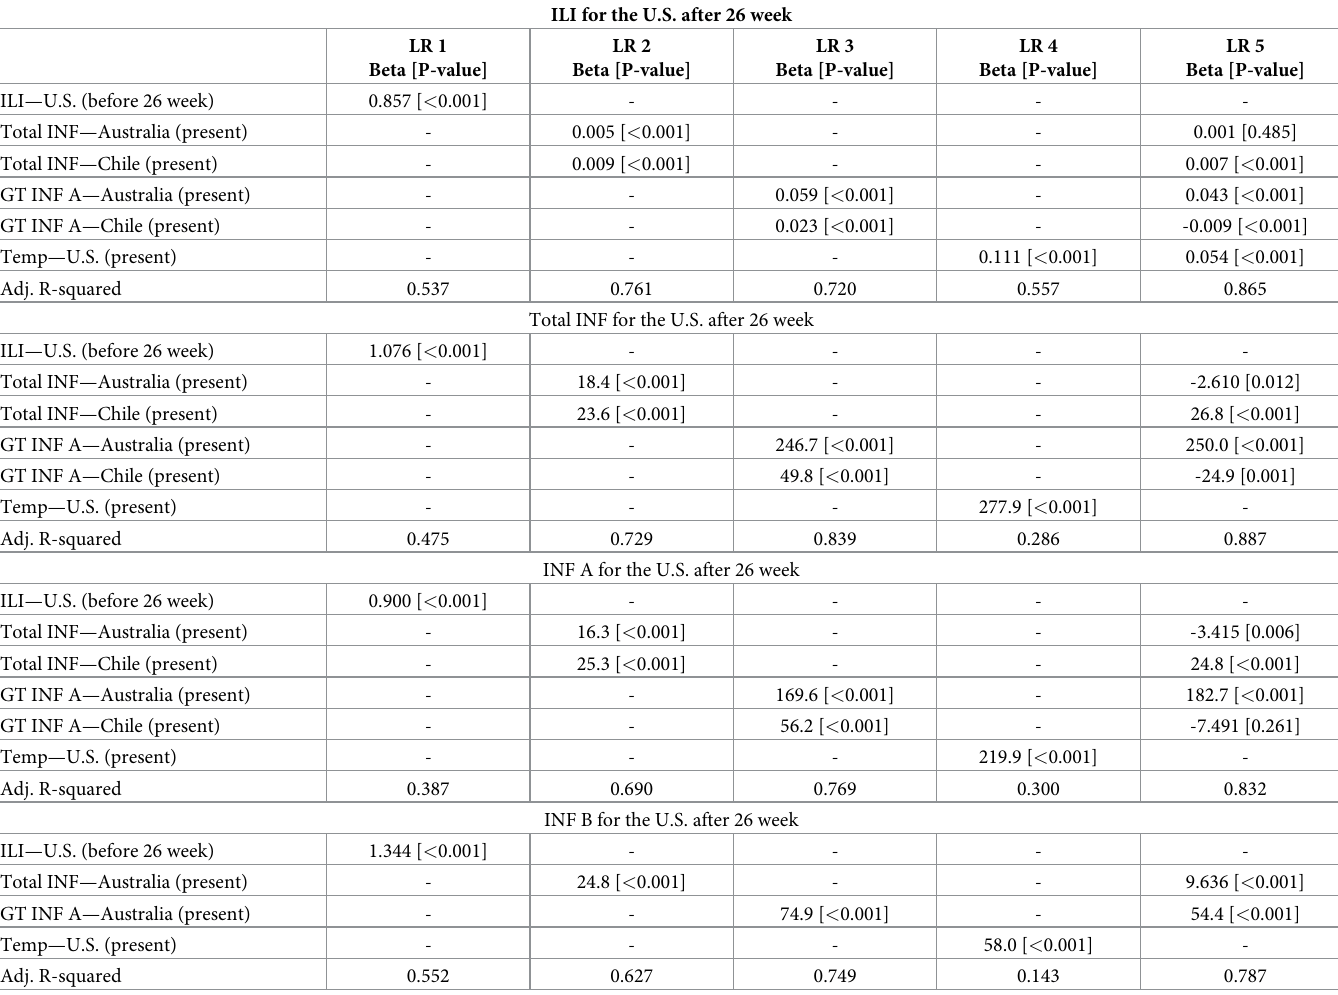
Table 2. Linear regression analysis for influenza activities of previous season in the U.S. and input variables from the 40 th week in 2010 to the 40 th week in